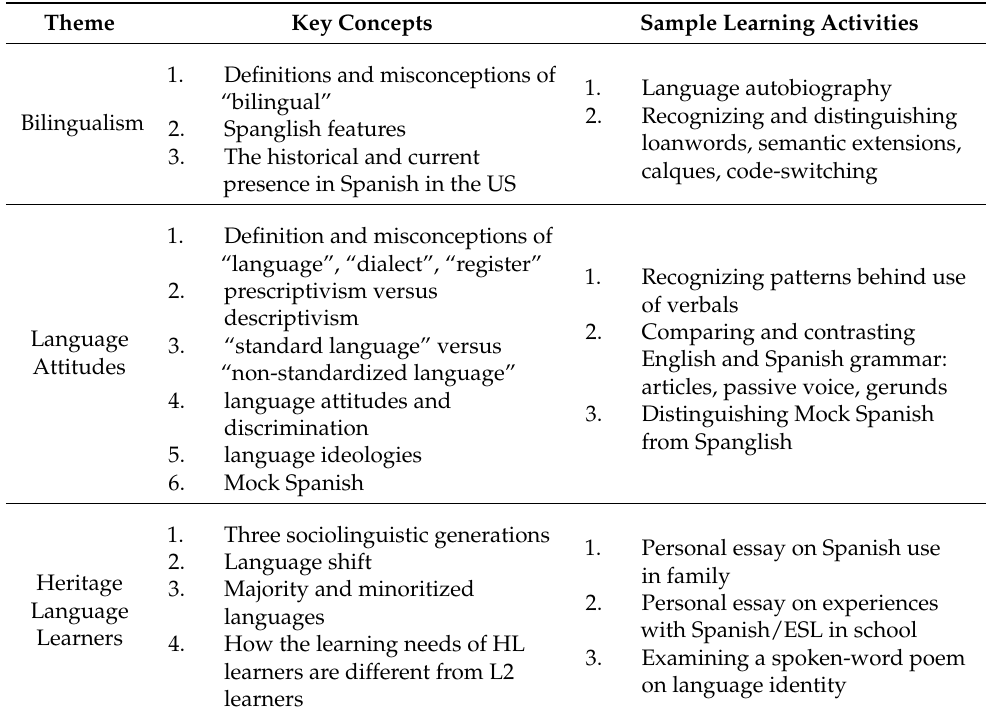
Table 1. Key concepts delivered across all five